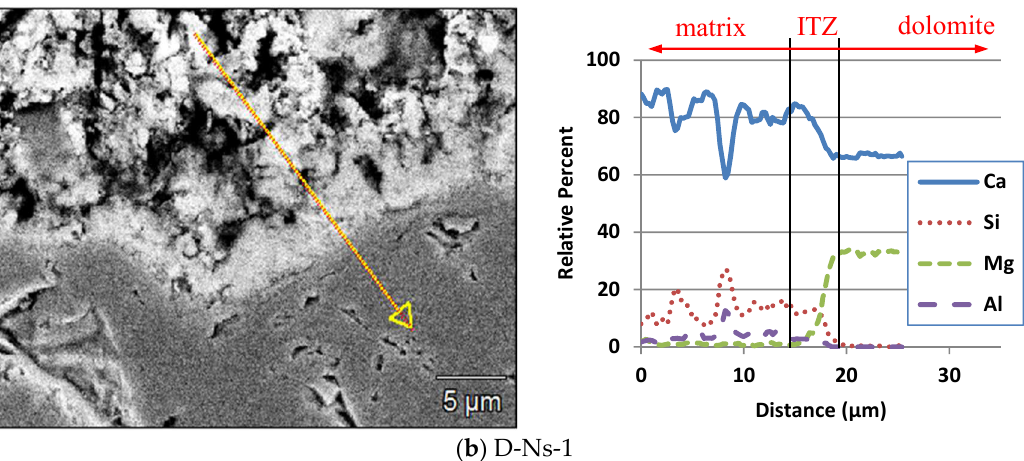
Figure 11. Line scanning analyses (SEM and energy dispersive X-ray (EDX)) of ITZ regions for dolomite concrete mixtures.